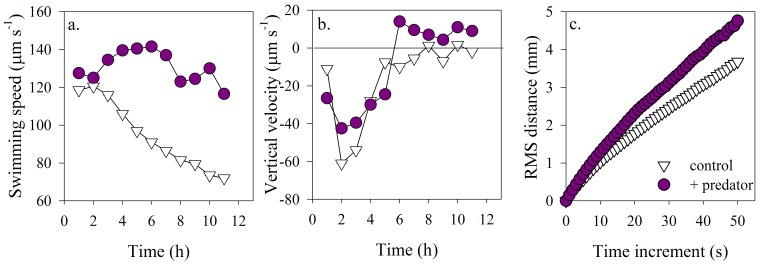
Below halocline movement behaviors.Mean (a) swimming speed (µm s−1), (b) mean vertical velocity (µm s−1), and (c) root mean square distance (RMSD) (mm) of H. akashiwo in the absence (white triangles) and presence of the ciliate predator (purple circles) below the halocline. Error bars here and in all figures are one standard error (SE) of the mean. Frequently SE was small and contained within the symbols. Movement behaviors reflect significantly greater speed and upward motility below the halocline in response to the presence of the predator.